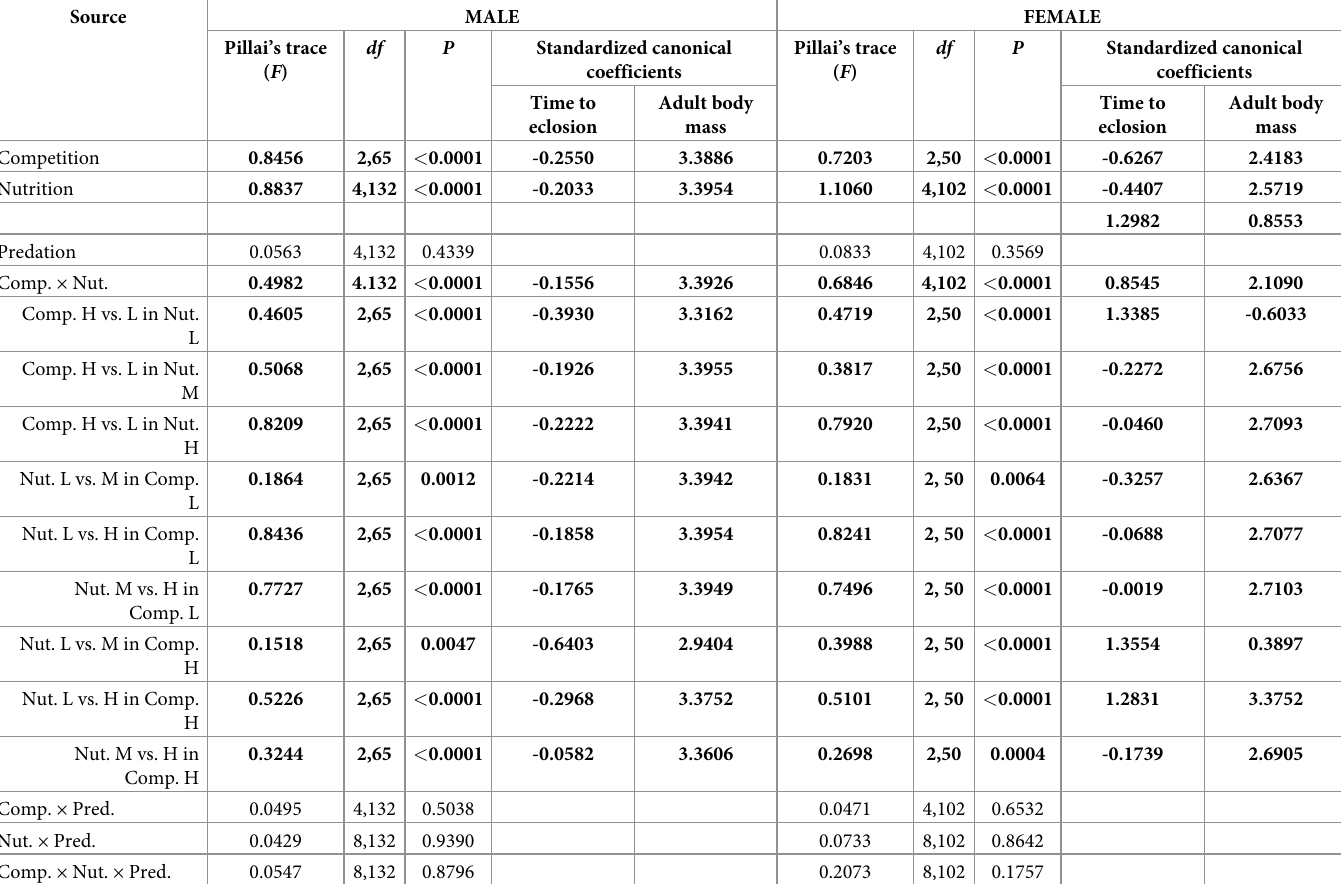
Table 2. Time to eclosion and adult body